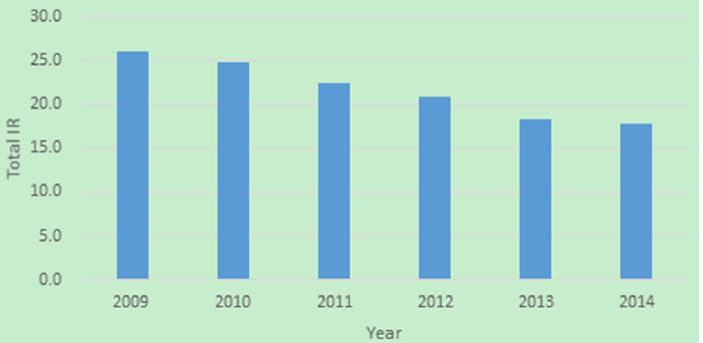
Figure 3. The average IRs of TB overall across the districts of Beijing from 2009 to 2014.